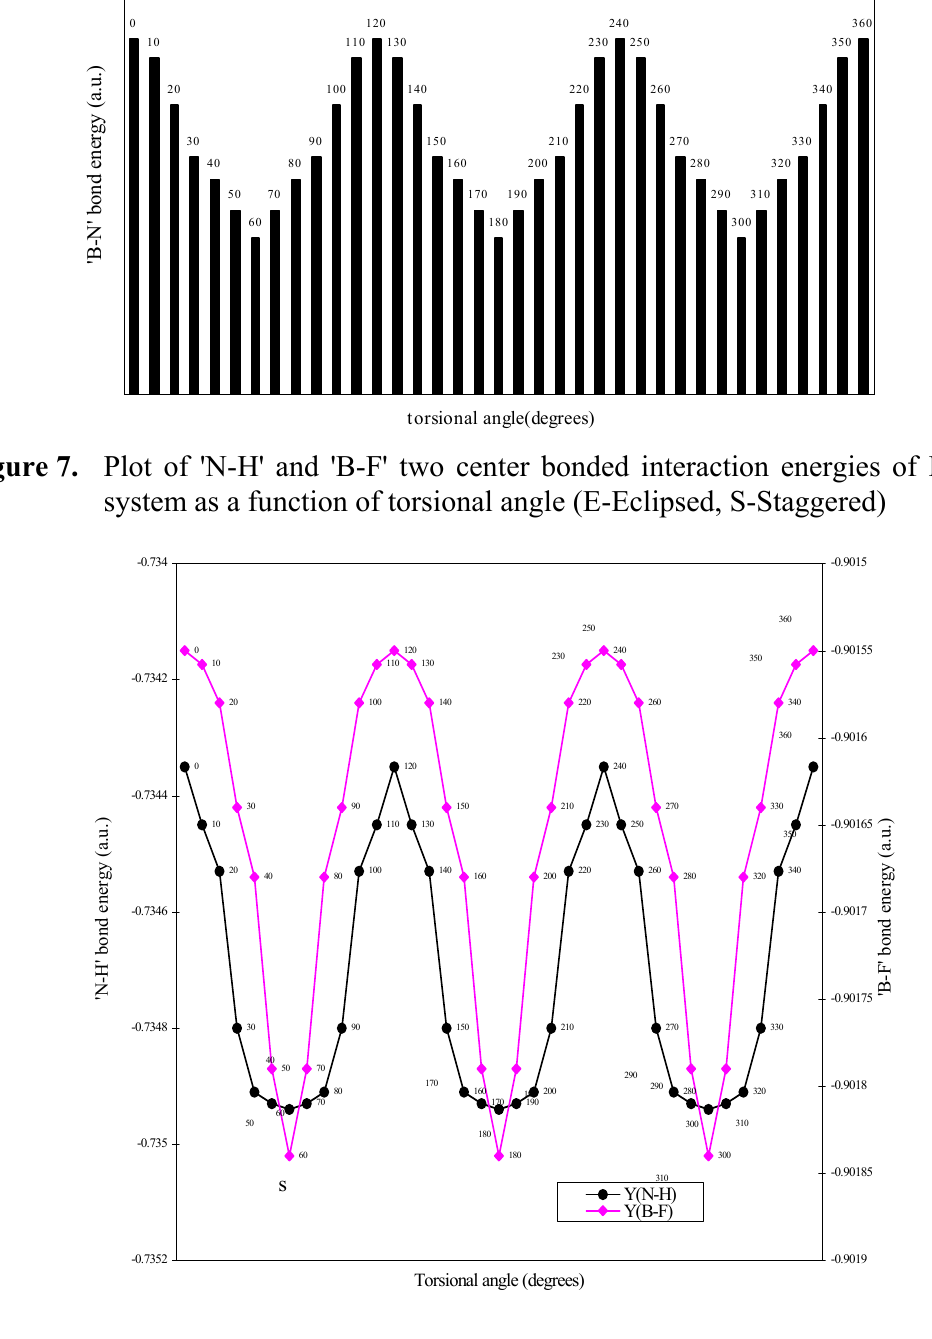
Figure 6. Plot of 'B-N' bonded interaction energy of F torsional angle.